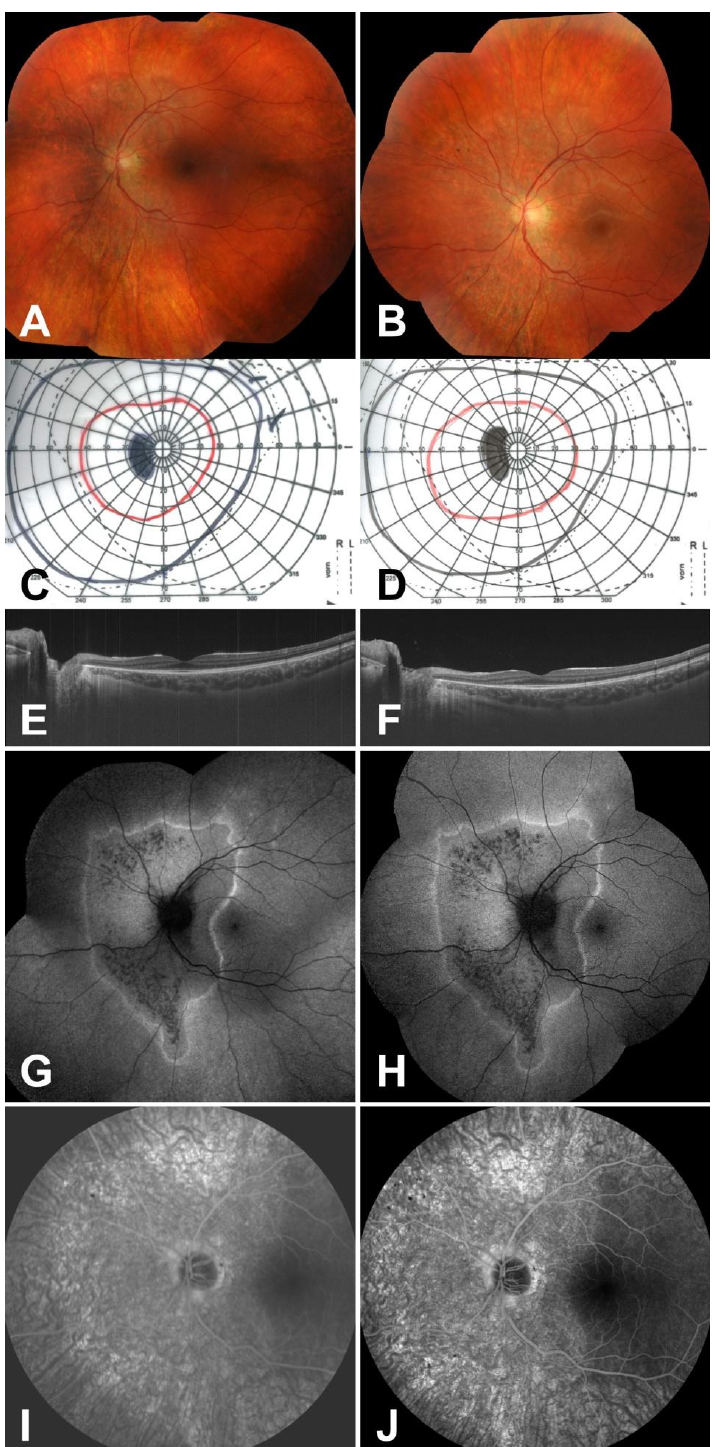
Figure 1. Changes in the affected eye on imaging tests on admission ( A , C , E , G , I ) and at five-year follow-up ( B , D , F , H , J ). Color fundus photography shows only an area of a thinner retina with some hyperpigmentation ( A ), as well as more pronounced hyperpigmentation and atrophic lesions after five years ( B ). Kinetic perimetry shows a slight enlargement of the blind spot ( C , D ). Swept-source optical coherence tomography reveals peripapillary disruption of the ellipsoid zone ( E , F ). Fundus autofluorescence shows an abnormal area encircled by a rim of high autofluorescence. The size of the spared perifoveal area remained stable on follow-up examinations ( G , H ). Fluorescein angiography (late phase) shows a peripapillary window defect of a similar extent comparing early and late phase ( I , J